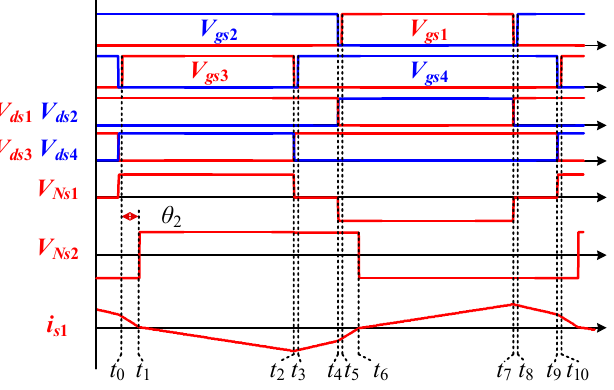
Figure 6. Operating waveform of the basic cell without PV source.